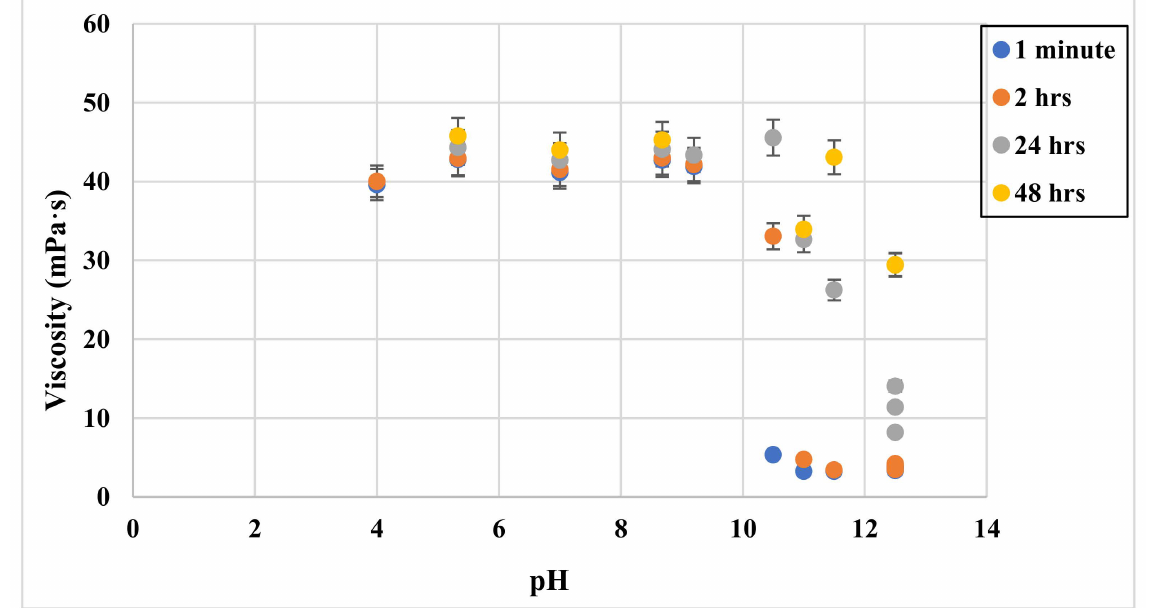
Figure 6. Viscosity versus GLDA pH at 1 min (blue circle), 2 h (red circle), 24 h (black triangle), and 48 h (yellow